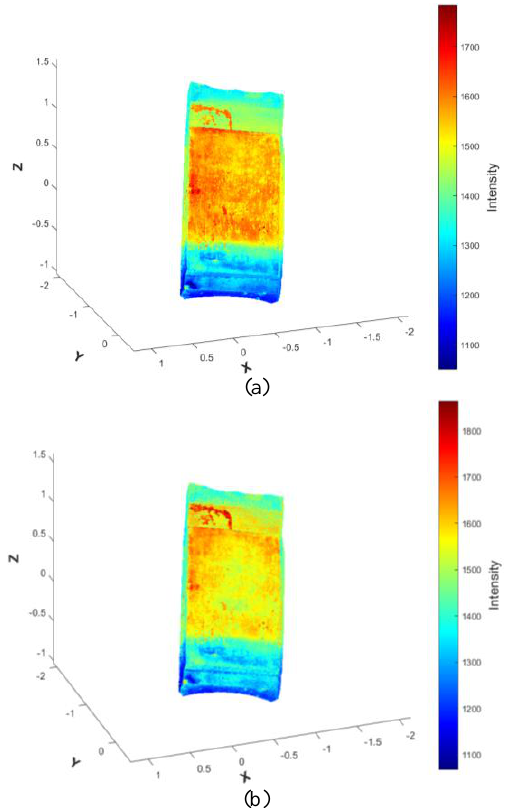
Figure 8. 3D point cloud intensity correction visualization: (a) Wall 1 before correction; (b) wall 1 after correction;